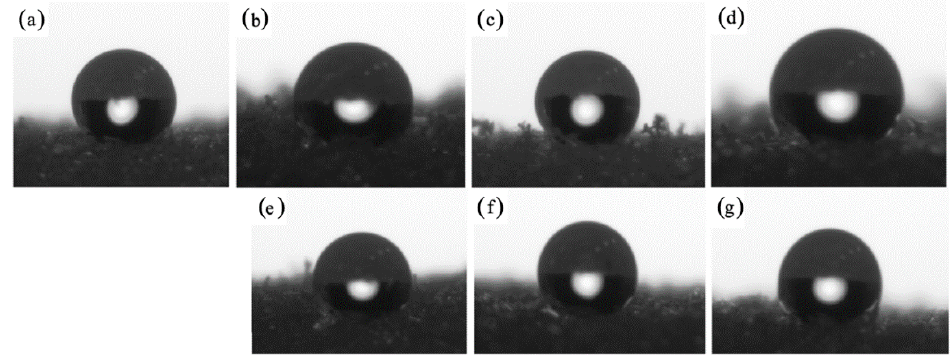
Figure 11. Selected properties of PUR foams: water uptake and contact angle results.